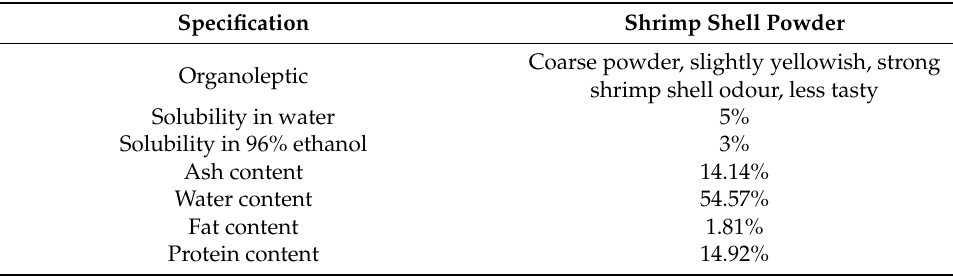
Table 4. Characteristics of shrimp shell